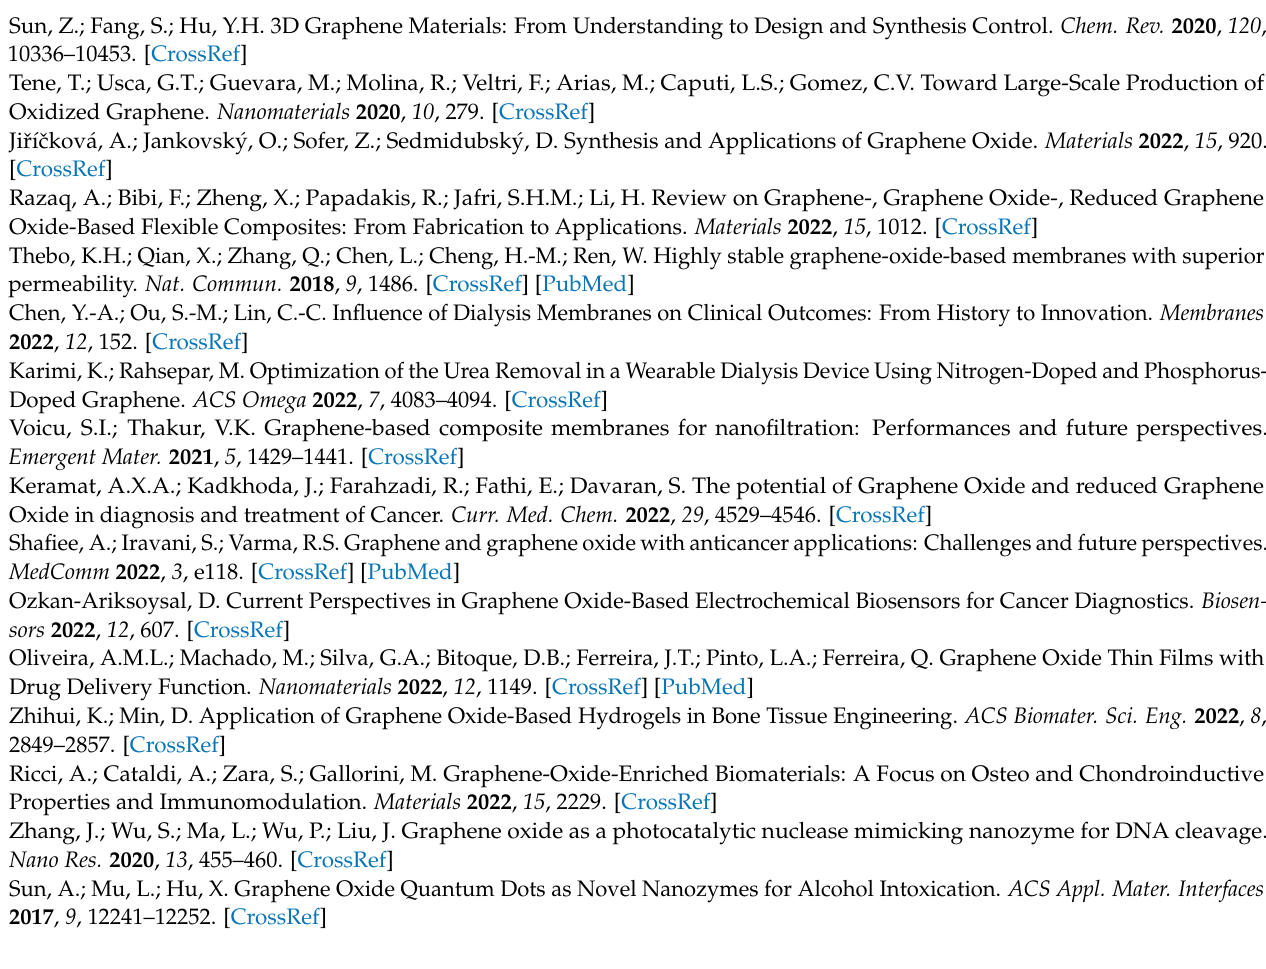
Table S2: Quantity of graphene oxide acidity groups estimation; Table S3: C/O ratio estimation by different methods; Table S4: Phthalate estimation by GC-MS. References [143–159] are cited in the Supplementary